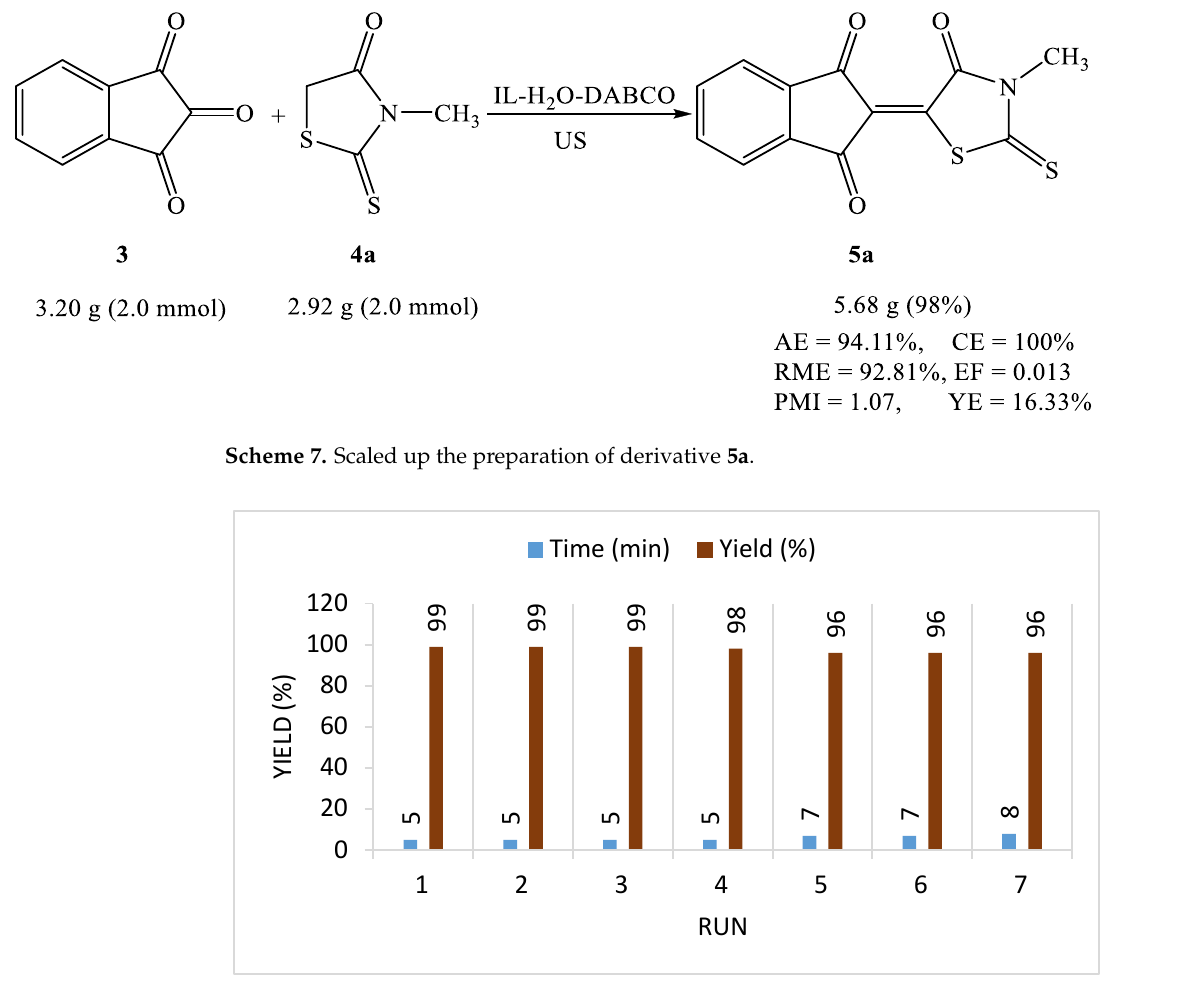
Figure 2. The evaluation of the reusability of the IL ( 2 ) for the preparation of 5a .